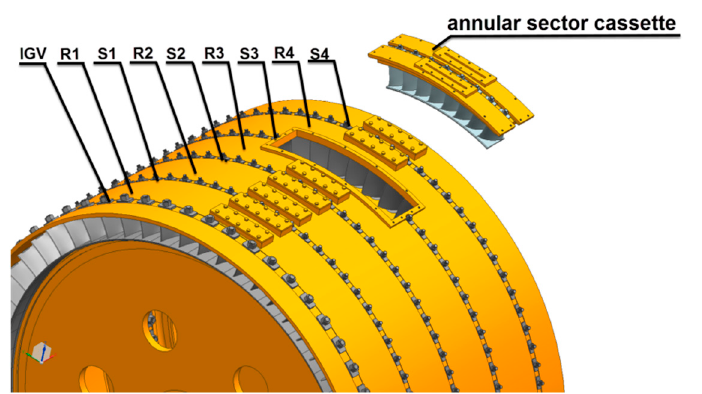
Figure 7. A sketch of the annular sector cassette test platform.